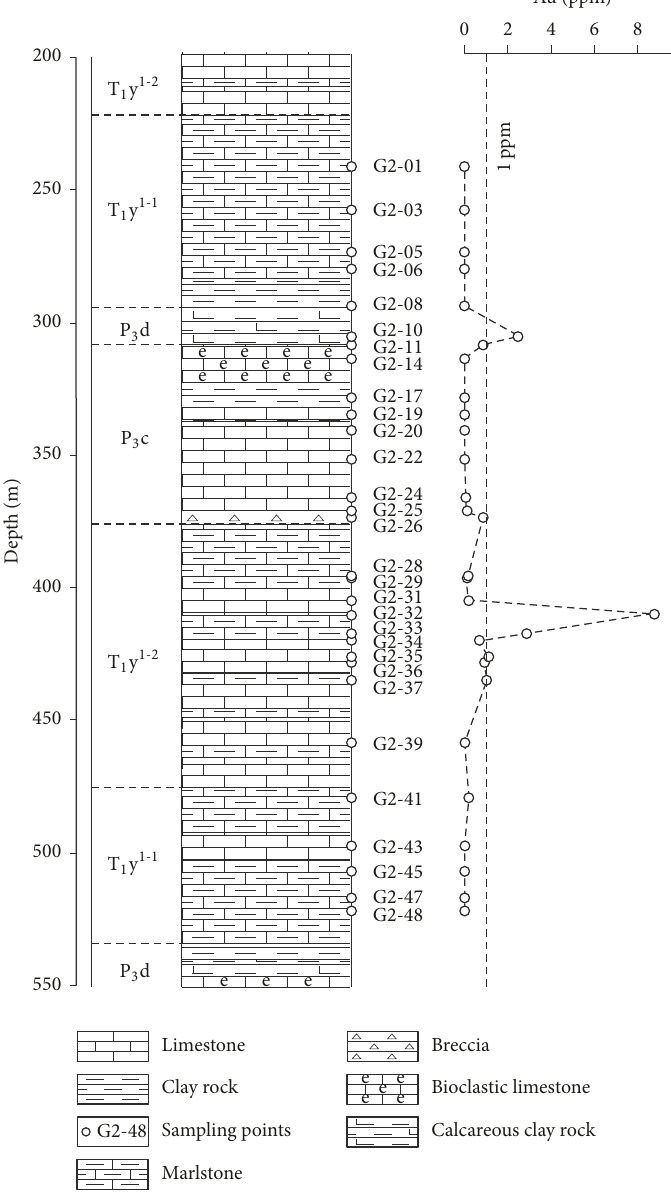
Figure 3: Generalized lithological column of well G2 in the Bojitian gold